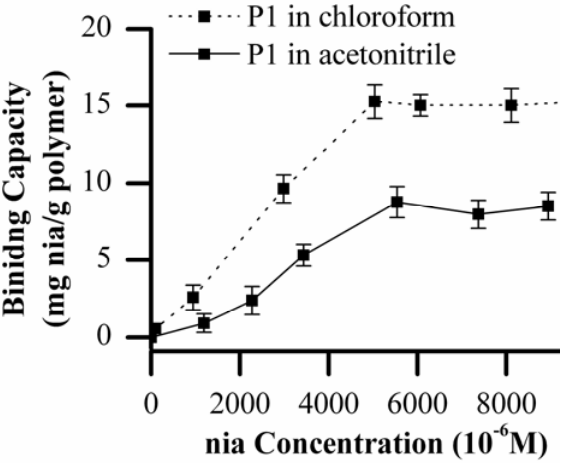
and MeCN versus nia 3